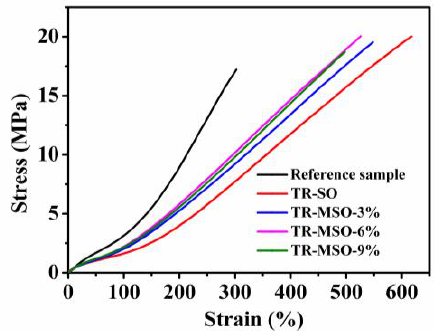
Figure 4. Stress-strain curves of tread rubber with different plasticizers. Table 4. Mechanical properties of tread rubber with different plasticizers.